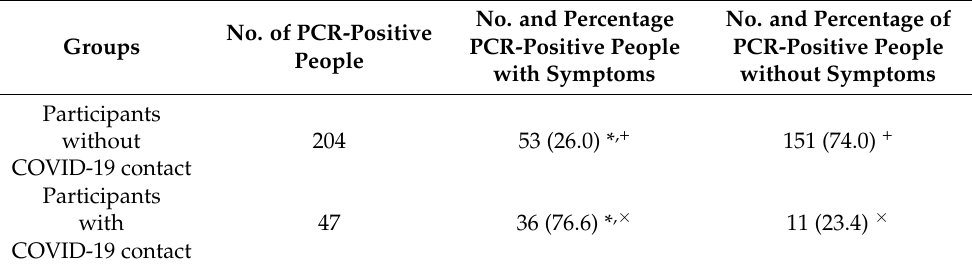
Table 5. Direct comparison of PCR positivity with COVID-19 symptoms in groups of participants with or without COVID-19 contacts from September 2020 to March 2021.